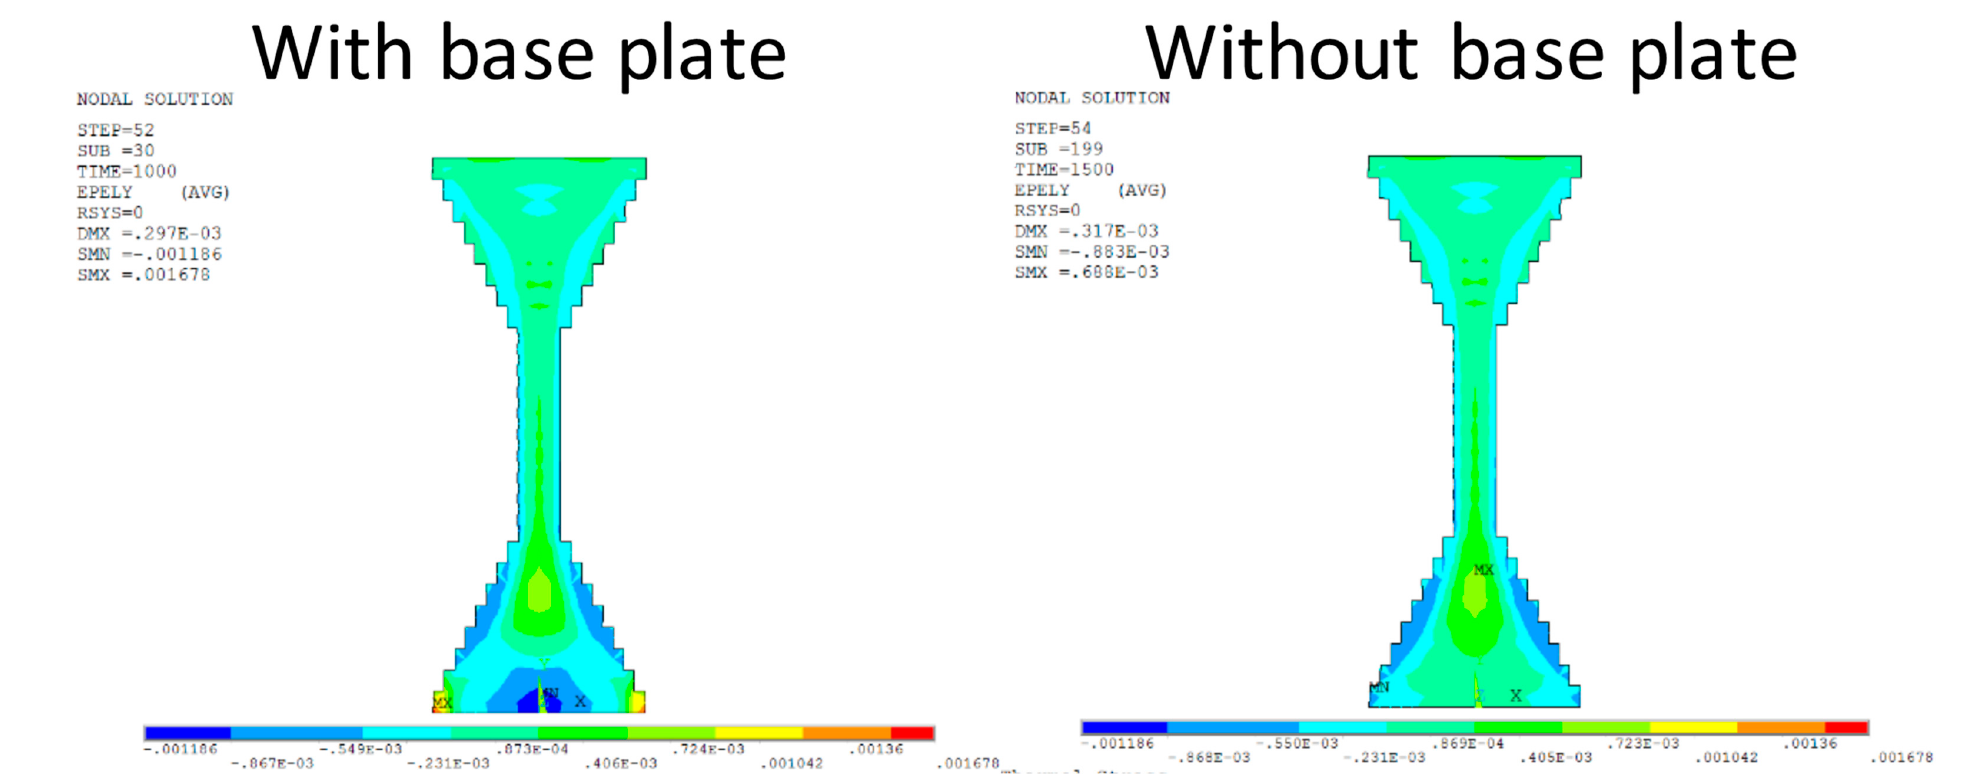
Figure 9. Simulation results from the FEA model, with and without the base plate.